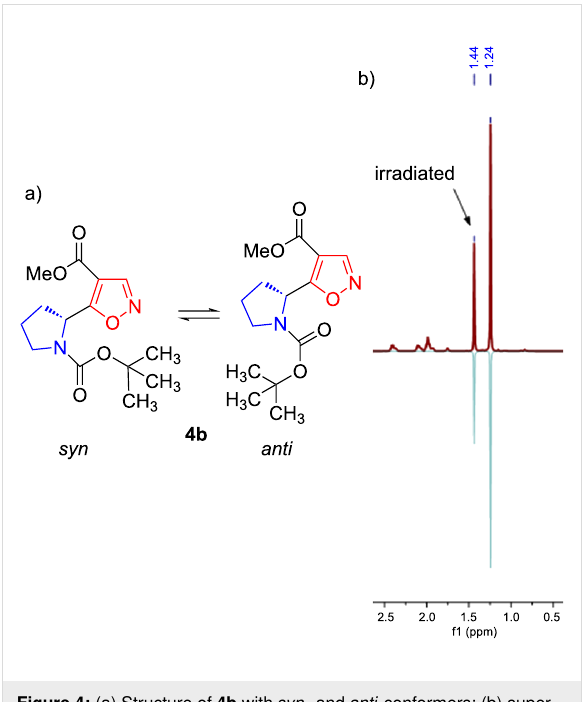
Figure 4: (a) Structure of 4b with syn - and anti -conformers; (b) super- imposed 1 H NMR and 1D gradient NOE spectra with a selective irradi- ation of signal at δ 1.44